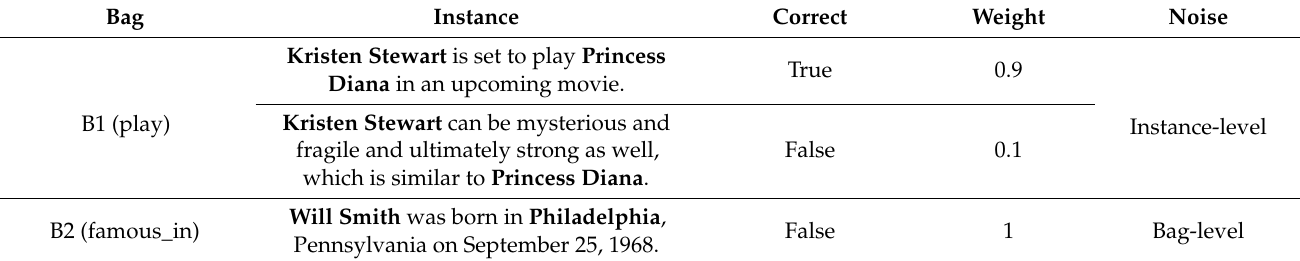
Table 1. Examples of instances of wrong labeling by distant supervision. There are two bags of instances B1 and B2 in the table, which are labeled with “play” and “famous_in”, respectively. The bold words in instances are entities. The first instance in B1 is correctly labeled, and the second is wrongly labeled due to the strong assumption of distant supervision. In this situation, the selective attention mechanism might assign 0.9 and 0.1 weights to the two instances, respectively. Meanwhile, only the one instance in B2 is mislabeled due to the incomplete knowledge graph and its weight will be set to 1 in selective attention. Therefore, there is instance-level noise in B1 and bag-level noise in B2,